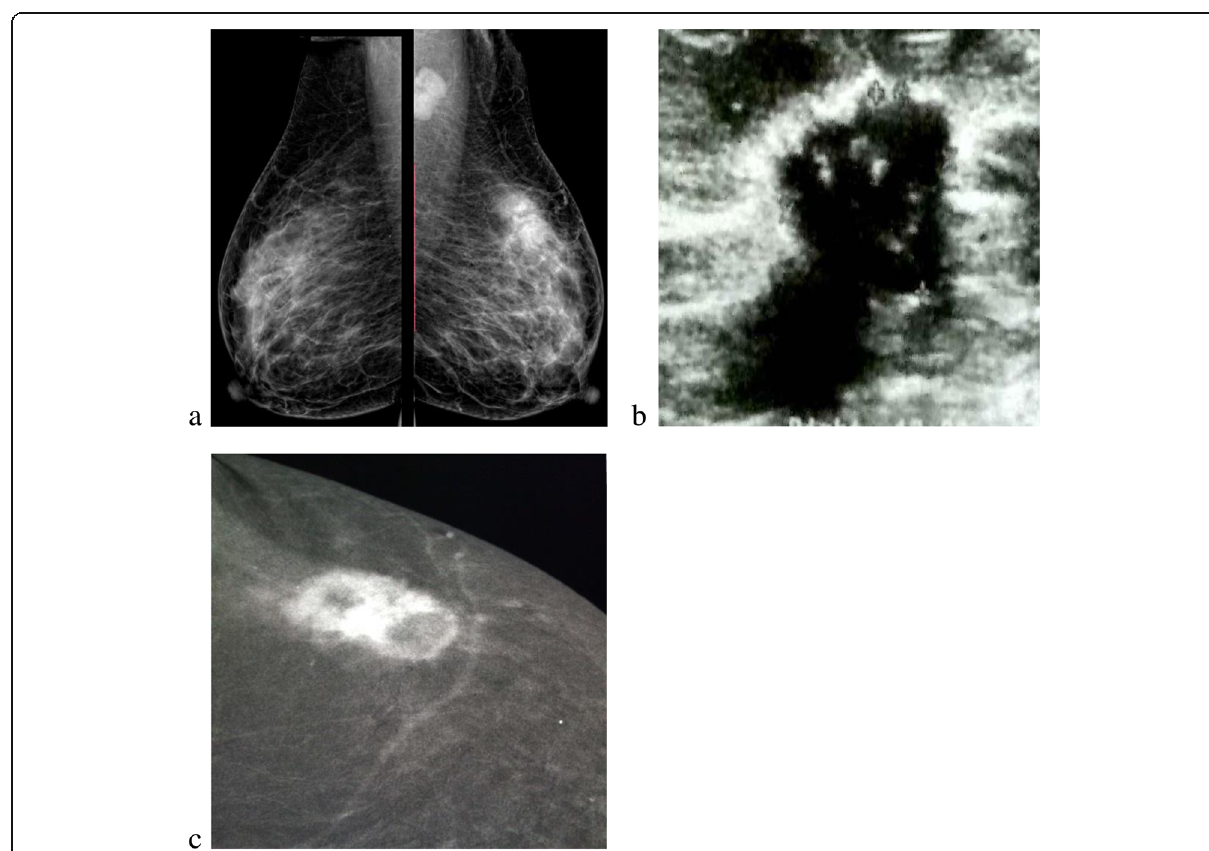
Fig. 3 A case of invasive ductal carcinoma represented by left focal asymmetry ( a ) and shows an irregular speculated margin hypoechoic mass on ultrasound ( b ). Recombined image of CEDM shows a mass with ring enhancement in the recombined image ( c